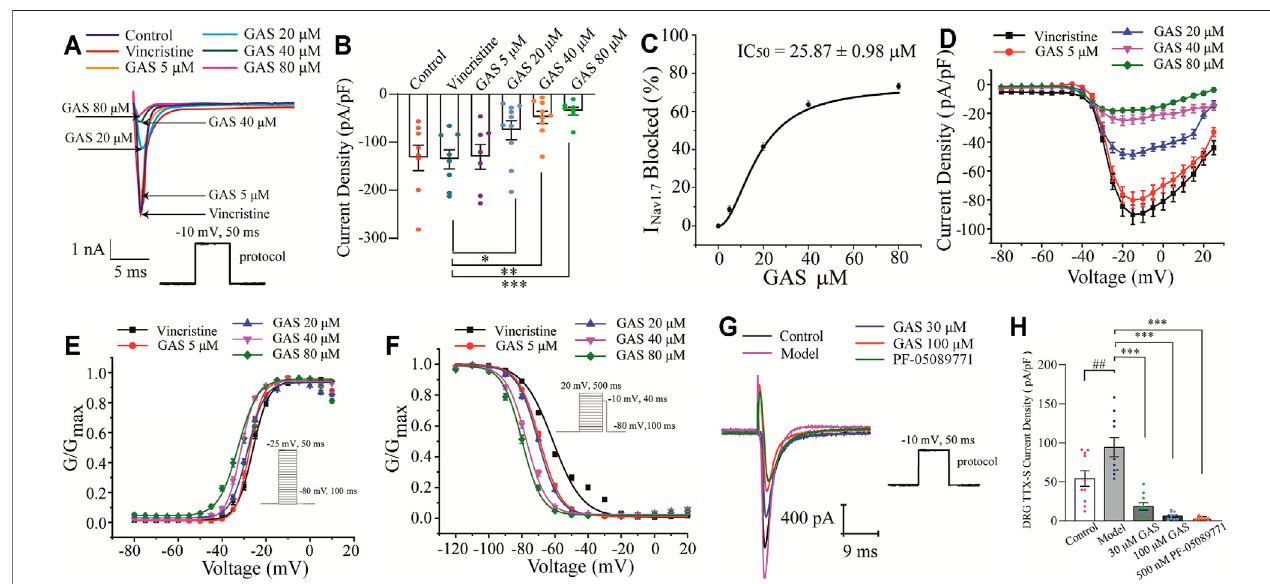
FIGURE 3 | In fl uences of GAS on Na V 1.7 channel current: (A) typical inhibition curve of GAS on Na V 1.7 channel current; (B) histogram of the in fl uence of GAS on Na V 1.7 channel current density; (C) concentration-response curves of GAS on Na V 1.7 current (IC 50 (cid:1) 25.87 ± 0.98 μ M); (D) the in fl uence of different concentrations of